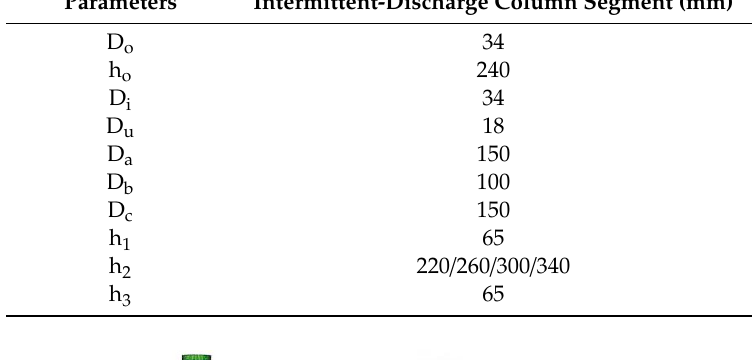
Table 2. Structural parameters of the hydrocyclone.